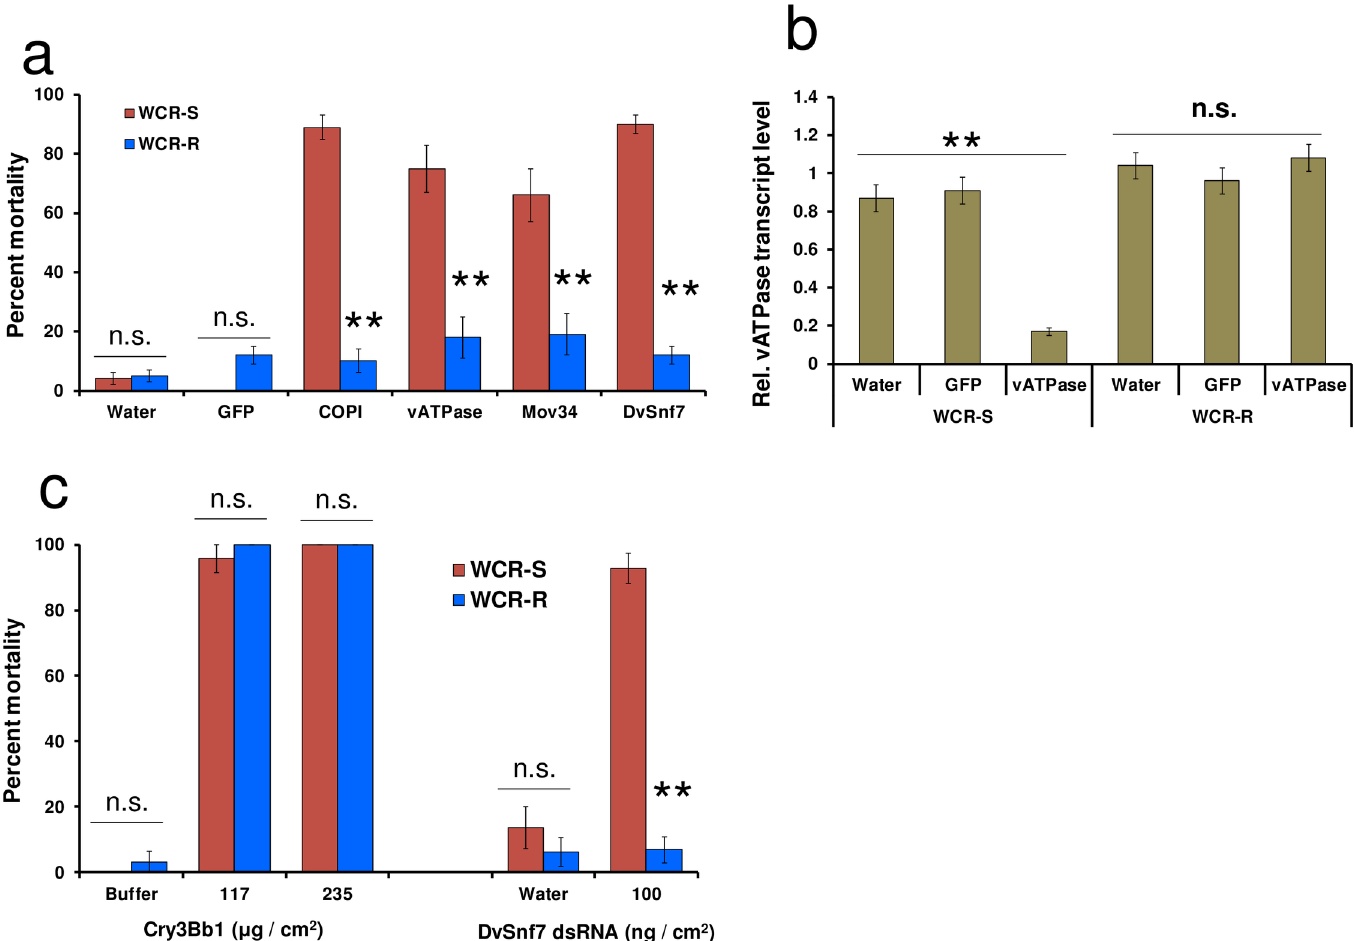
Fig 3. WCR-R is cross resistant to multiple insecticidal dsRNAs but not to Bt Cry3Bb1. ( a ) Percent larval mortality of WCR-R and WCR-S fed artificial diet surface- treated with 300 ng /cm 2 dsRNA (GFP, COPI β , vATPase A, mov34 or DvSnf7) or water. Each treatment was conducted one to three times, with four replications per trial. WCR-R: n = 28–94; WCR-S: n = 29–93. ( b ) Relative vATPase A transcript levels in WCR-R and WCR-S larvae fed for 72 hr on artificial diet surface-treated with 300 ng / cm 2 of dsRNA (vATPase A or GFP) or water. Each treatment consisted of five replications, each consisting of three larvae assayed together with two technical replications. n = 15. ( c ) Percent mortality of WCR-R and WCR-S larvae fed artificial diet surface-treated with Cry3Bb1, buffer, DvSnf7 or water. Mortality for Cry3Bb1 was evaluated on day 6 and on day 12 for DvSnf7 dsRNA. Each treatment was conducted once with four replications ( n = 22–32). All figures show means ± SEM. (cid:3)(cid:3) p < 0.0001.